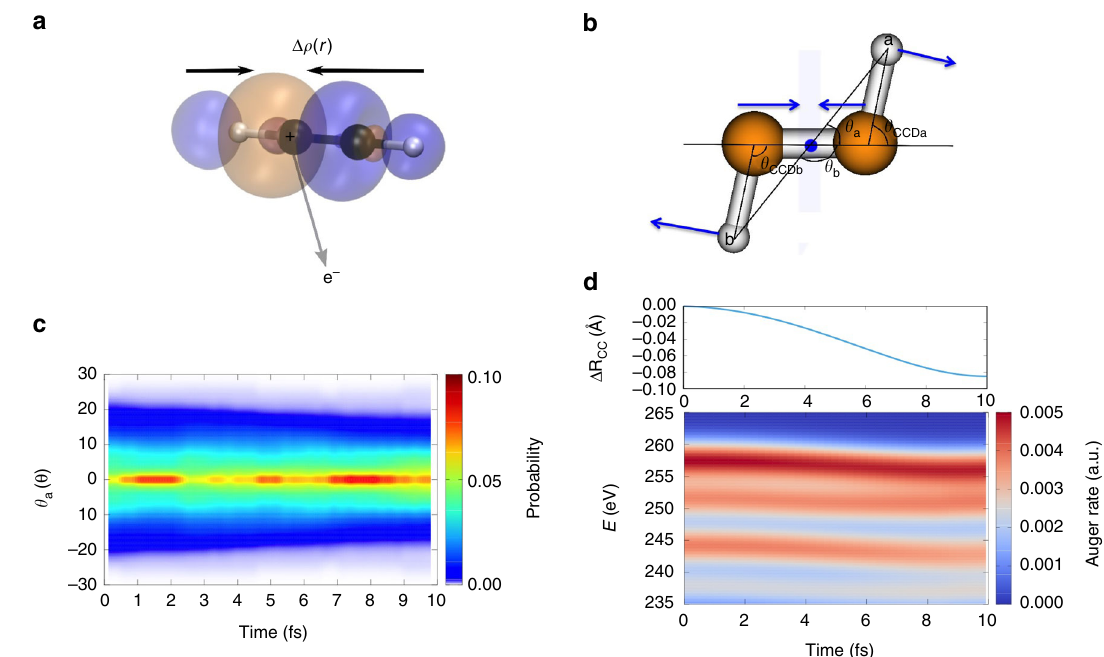
Fig. 2 Dynamics of the core ionized acetylene cation. a The relaxed electron density ρ (cid:1) 1 ð r Þ after carbon K edge photoionization. Δ ρ ð r Þ ¼ ρ (cid:1) 1 ð r Þ (cid:1) ~ ρ (cid:1) 1 ð r Þ is shown, where ~ ρ (cid:1) 1 ð r Þ is the electron density of the unrelaxed core hole state after removing one electron from C 1s orbital. b Characteristic motion of cation, C – C bond contraction and CCD linearization. c Evolution of the CCD angle θ a shows the cation evolves towards a narrower angular distribution. d The time- resolved Auger spectra from a representative trajectory and the evolution of C – C bond length and kinetic energy of Auger electrons. The contracting C – C bond results in a red shift of Auger electron energies. The Auger spectra are broadened by a Lorentzian corresponding to a core-hole lifetime of 8